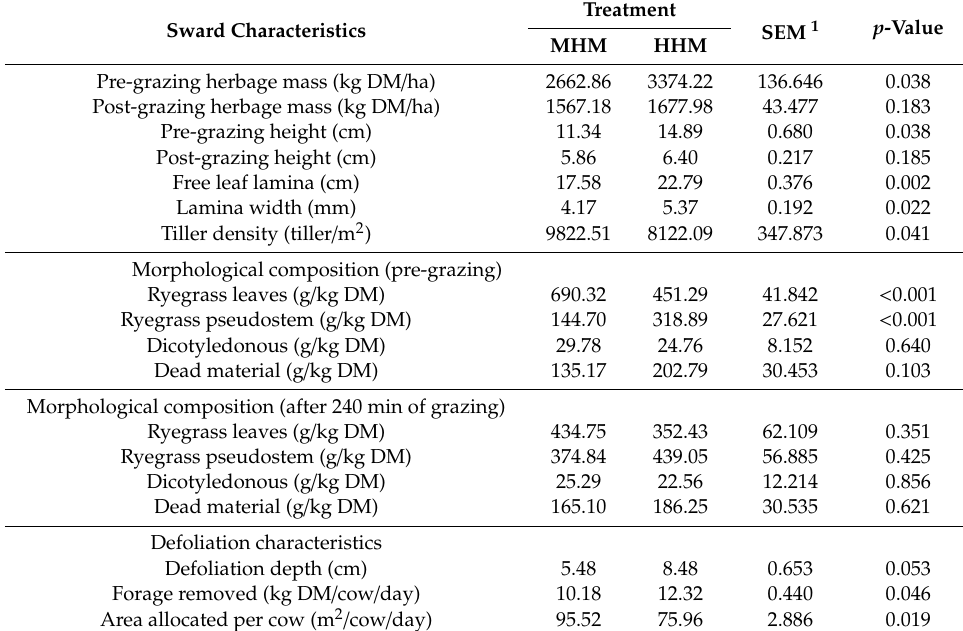
Table 1. E ff ect of a medium (MHM) and high (HHM) pre-grazing herbage mass on sward measurements and defoliation characteristics of a pasture grazed by dairy